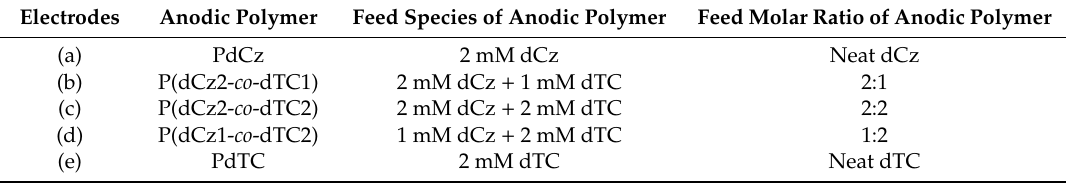
Table 1. Feed species and molar ratio of anodic polymer electrodes